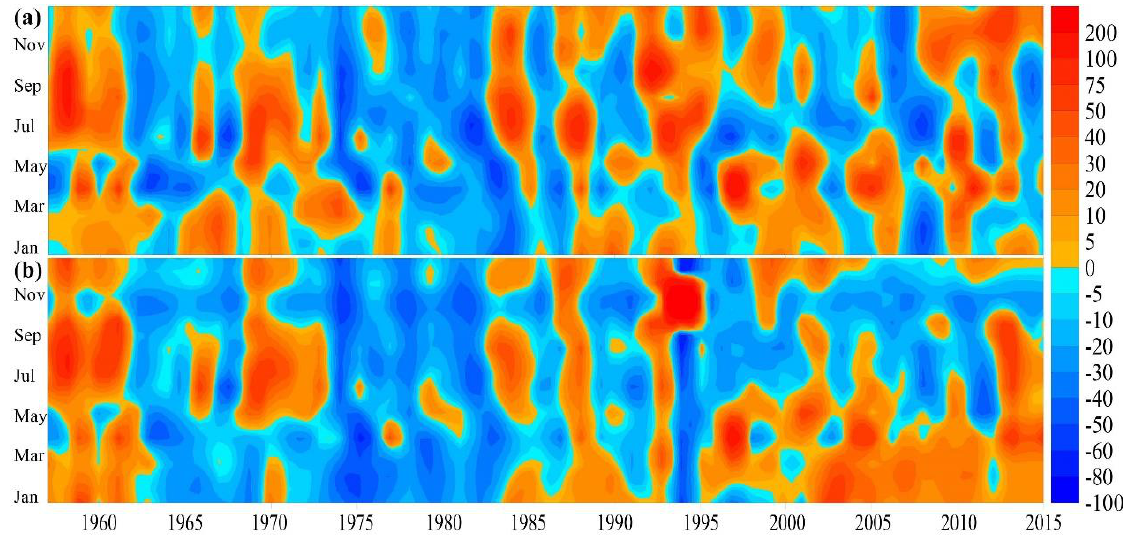
Figure 6. Variations in the observed monthly streamflow anomalies (%) during the period 1957– 2015 at the ( a ) Kuwei and ( b ) Kelatashi national hydrological stations in the